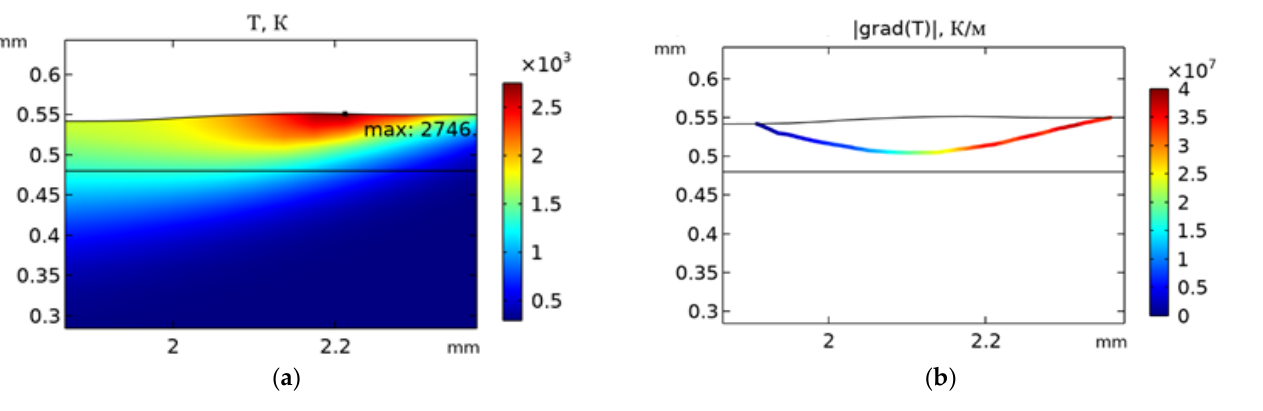
Figure 11. Characteristics of the molten pool calculated under condition of the permanent magnetic field at B z = 0.1 T: ( a ) temperature field and ( b ) distribution of the temperature gradient, where the color line provides the temperature gradient along the solidification front.